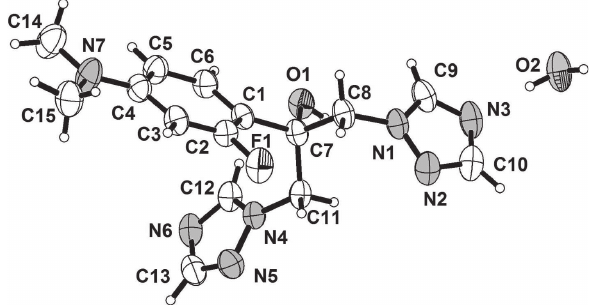
Table 1: Data collection and